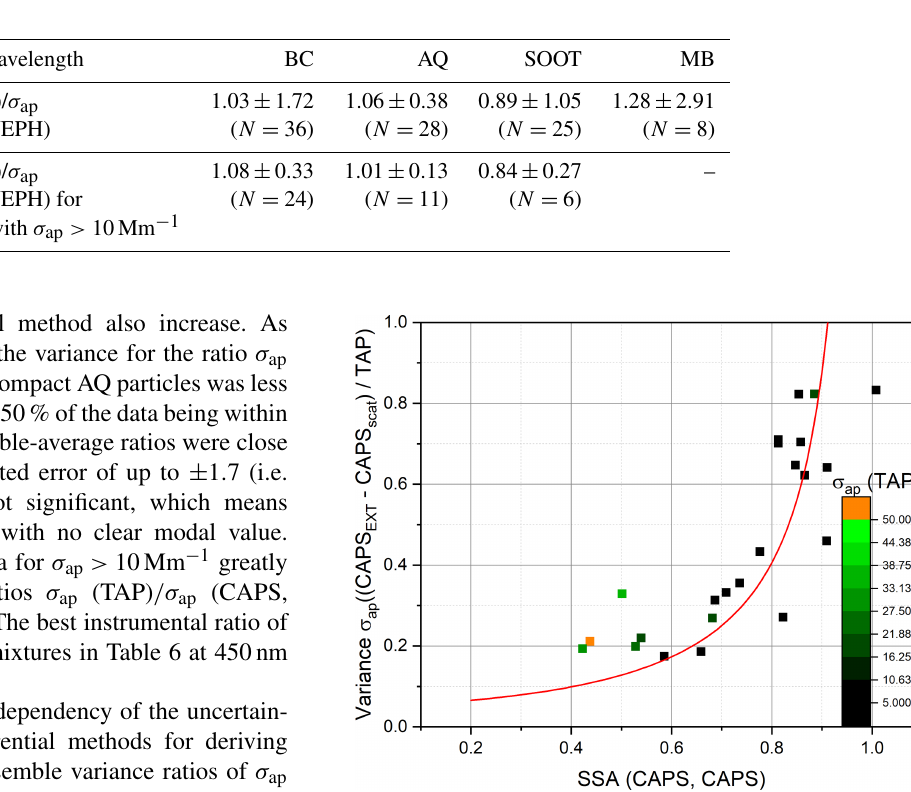
Table 6. Ensemble-average ratios of σ ap (TAP)/ σ ap (CAPS, NEPH) at 450nm wavelength. N denotes the number of experiments used for the average.